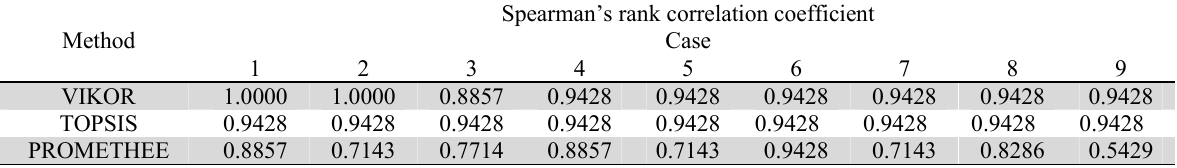
Spearman’s rank correlation coefficient Case